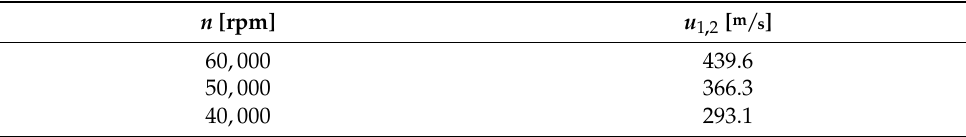
Table 5. The turbine operating points with calculated blade tip speed.